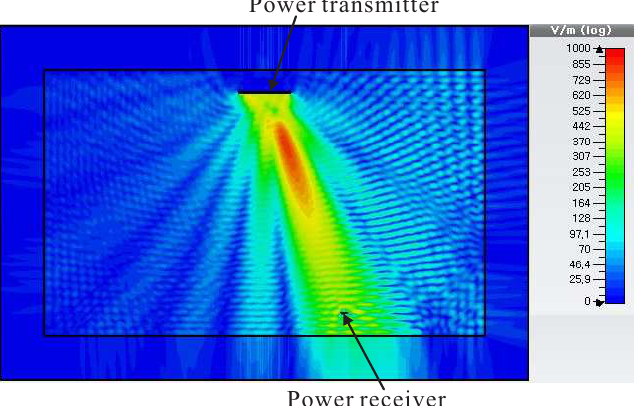
Figure 10. Simulated electric field distribution at 5.2 GHz when moving the power receiver away from the broadside